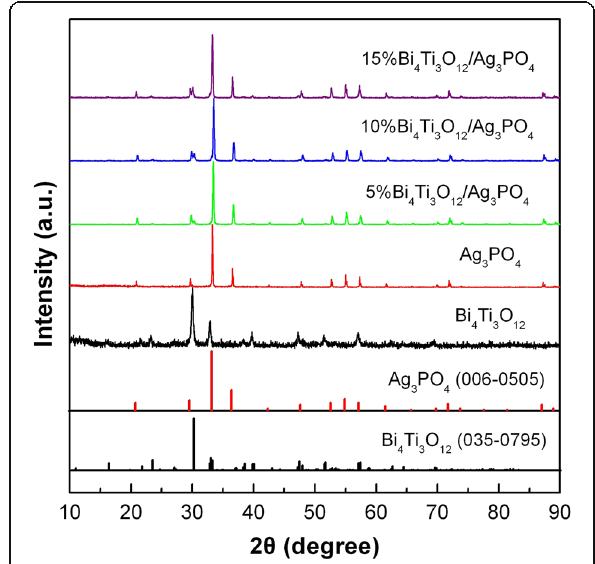
Fig. 1 XRD patterns of Bi 4 Ti 3 O 12 , Ag 3 PO 4 , and Bi